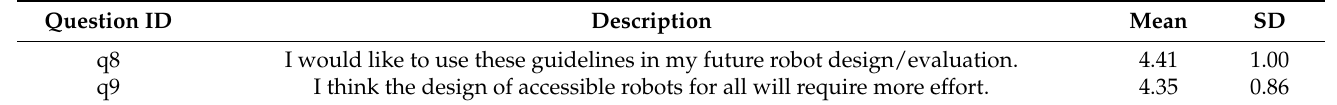
Table 5. Questions evaluating user satisfaction